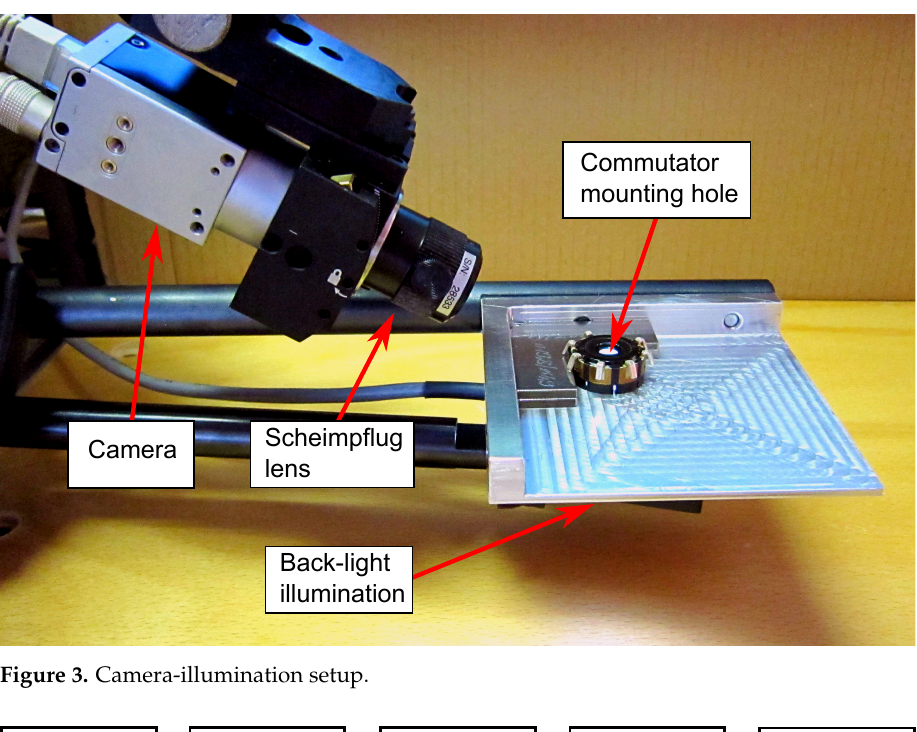
Figure 3. Camera-illumination setup.